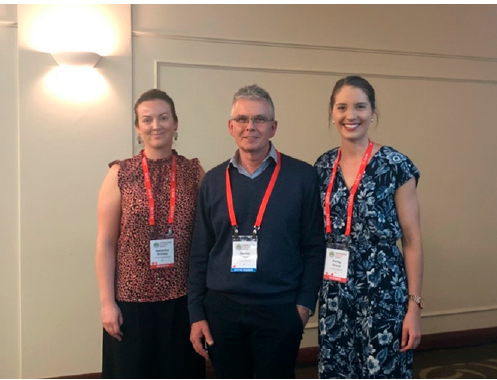
Figure 9. Inaugural Indigenous Virology Session speakers (from left to right), Samantha Grimley, Damian Purcell and Ashley Hirons.